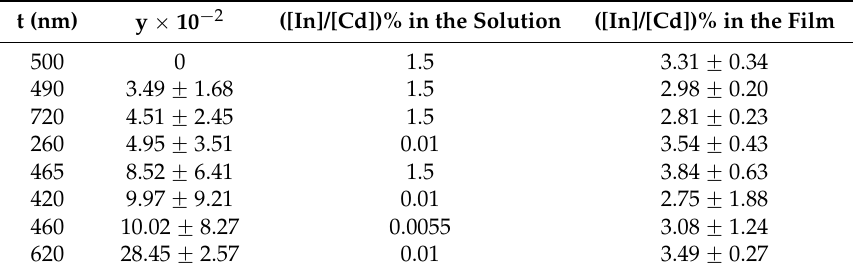
Table 1. The thickness t, Te molar ratio y, and percentage ratios of indium to cadmium concentrations in the precursor solution and in the films respectively. t